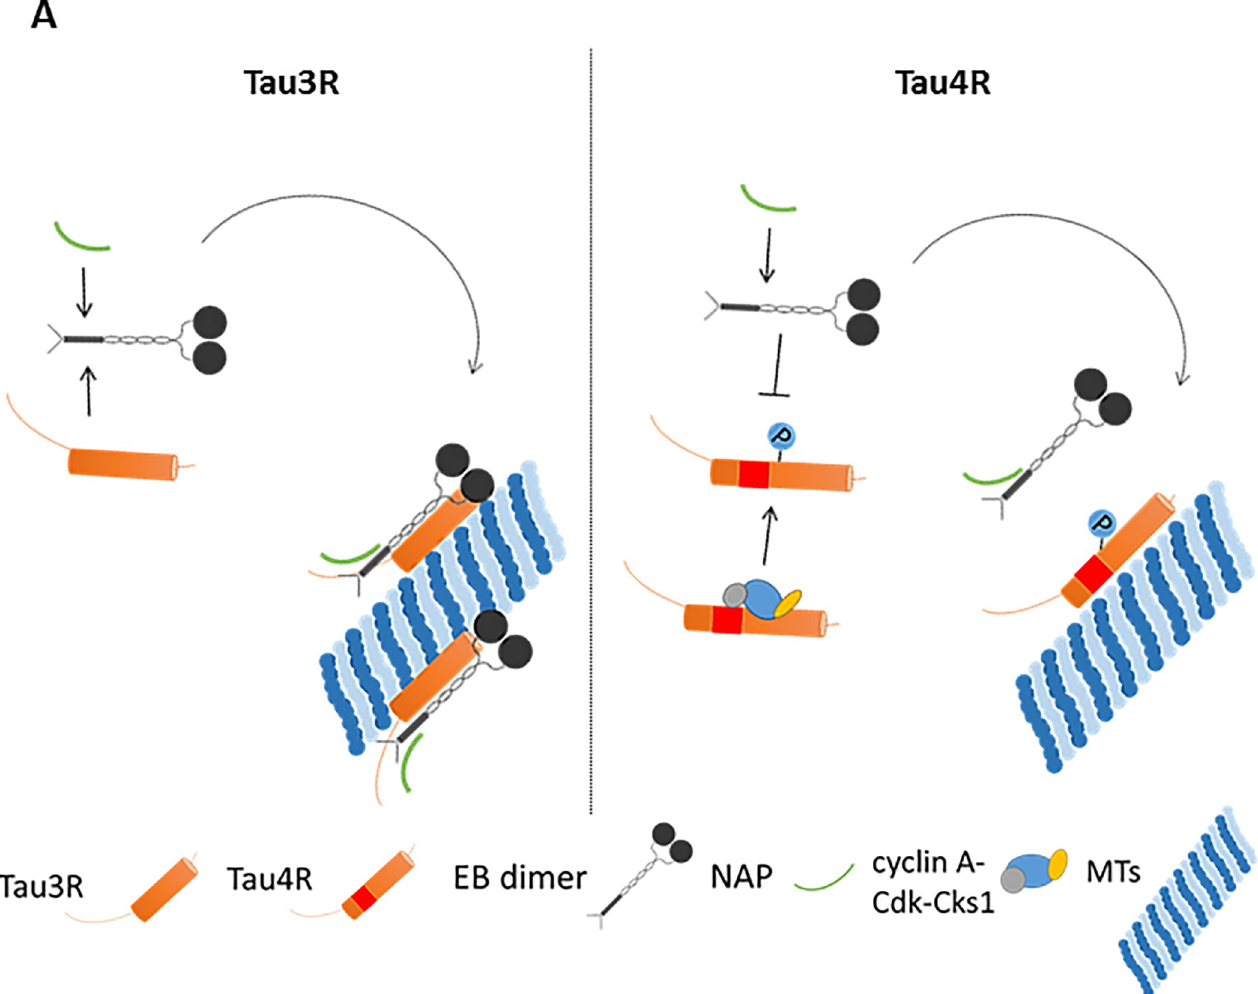
Fig 7. Suggested explanation for the preference of NAP binding to Tau3R over Tau4R. Graphic depiction of our hypothesis suggesting the preference of NAP to interact with Tau3R based on the findings of the ELM prediction analysis and experimental results presented in Fig 6. The second MT-binding repeat of Tau4R (spliced in Tau3R) includes cyclin A-docking motif and thus may enable Tau binding to cyclin A, essential for the activation of Cdk1/2 [31]. Cks1 may also associate with Cdk and cyclin A to form more efficient cyclin A-Cdk-Csk1 phosphorylation complex. Tau4R phosphorylation by Cdk1/2 differs from Cdk5 (a conventional Tau kinase) [46] and may disturb/attenuate Tau-EB interaction, which has been previously indicated as a crucial for NAP interaction with MTs [16, 35]. The EB dimer structure was constructed according to a published review [42].